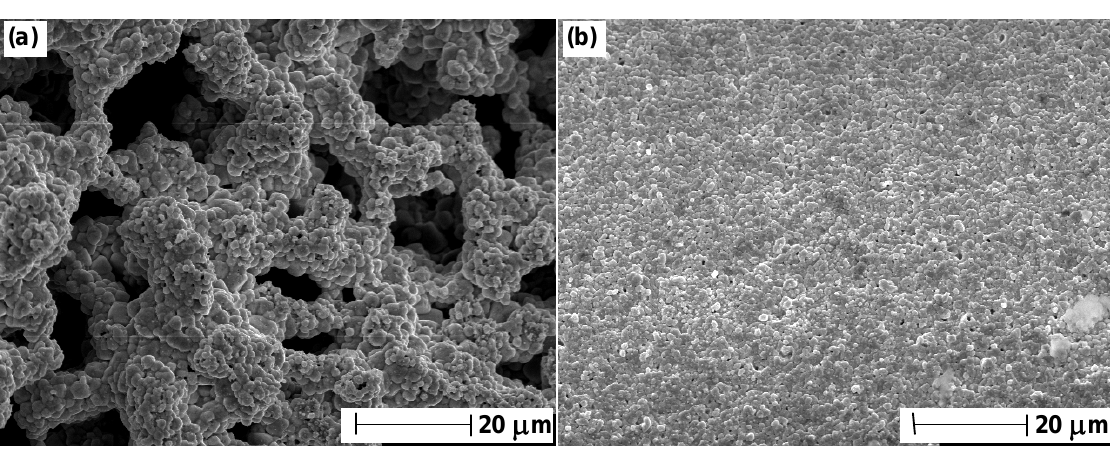
Figure 1. SEM images of (a) the spherical Ag/AgCl material from a thermal electrolytic electrode and (b) the Ag/AgCl material from an electrolytic